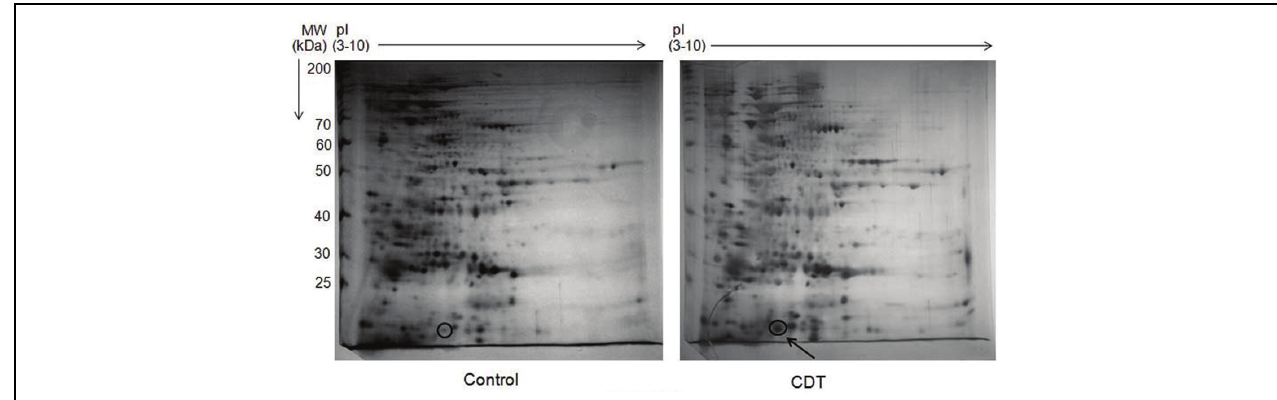
FIGURE 1 | 2D profile of rice seed proteins under control and CDT. Total 500 μ g of protein from Control and CDT treated seeds (6 days) was used for IEF using a non-linear IPG strip of pH 3–10. Second dimension was run on 12.5% SDS-PAGE and gels were stained with silver stain. Gel images were analyzed with Imagemaster 2D Platinum 7.0 (GE Healthcare) and differentially expressed spots were identified. Encircled spot was eluted and sequenced using MALDI-TOF/TOF.